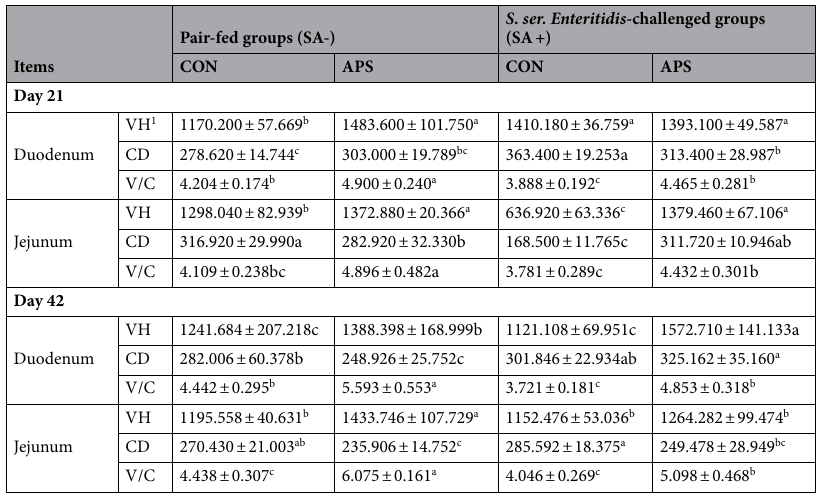
Table 1. Effects of supplementing alfalfa polysaccharide (APS) to S. ser. Enteritidis -challenged broilers on the small intestinal morphology. a-c Different letters in the same row indicate significant differences ( P < 0.05), and the same letters mean no significant difference ( P > 0.05). 1 VH, villus height. CD, crypt depth. V/C, the ratio of Villus height to the crypt depth.